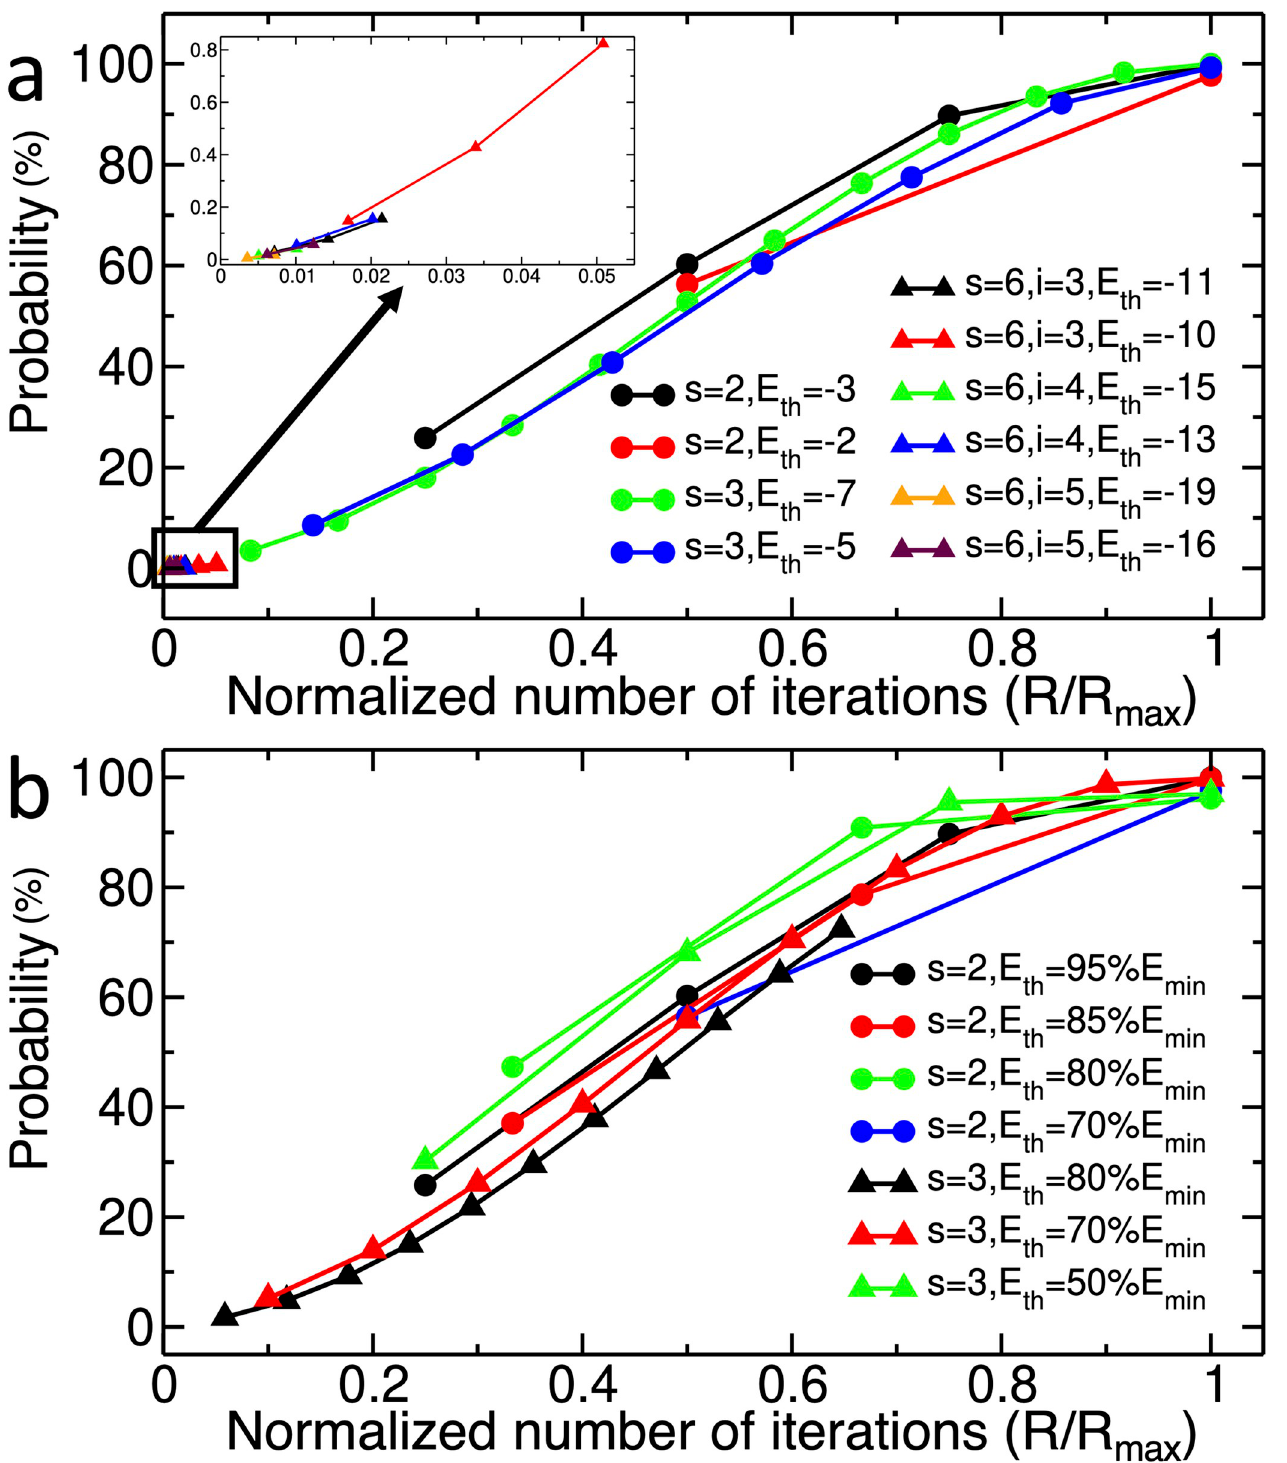
Fig 5. Probability of finding answer states in different systems as a function of normalized number of iterations ( R/R max ). Results for a) The SP model; b) The MR model; The inset in a), represents data for the first few R for systems with six designable sites.